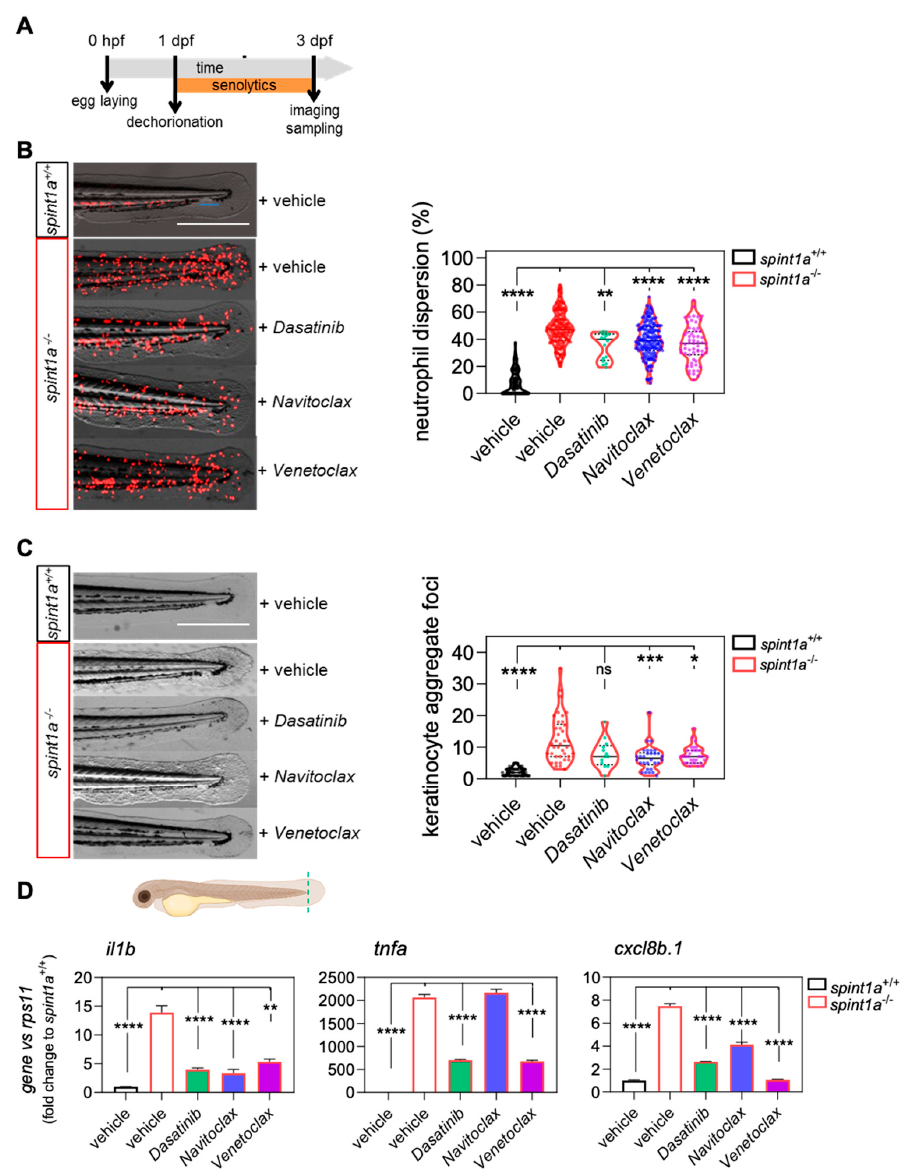
Figure 2. Senolytics ameliorate the skin inflammation phenotype of Spint1a-deficient larvae. ( A ) General workflow for the treatment with senolytics of the chronic skin inflammation zebrafish model (spint1a − / − ). ( B ) Representative images of neutrophil phenotype and quantification of the number of neutrophils out of the CHT of 3-dpf larvae with neutrophils labeled in red (lyz:DsRED2). ( C ) Representative images of skin phenotype and quantification of the keratinocyte aggregate foci at the skin. The violin plots with the median shown as a horizontal line show the distribution of DsRED2 + cells and keratinocyte aggregate foci, and are overlaid with the raw data, where each dot represents an individual. ( D ) The mRNA level of il1b, tnfa, cxcl8b.1 were determined by RT-qPCR and normalized against rps11 in fin folds (indicated at the scheme). The bars show the mean ± SEM of 20 pooled larvae ( n = 20) and triplicate samples from 2 independent experiments ( n = 2). ns, non-significant; * p < 0.05; ** p < 0.01; *** p < 0.001; **** p < 0.0001 according to Kruskal-Wallis followed by Dunn’s multiple comparison test. CHT: caudal hematopoietic tissue. Scale bars, 400 μ m.